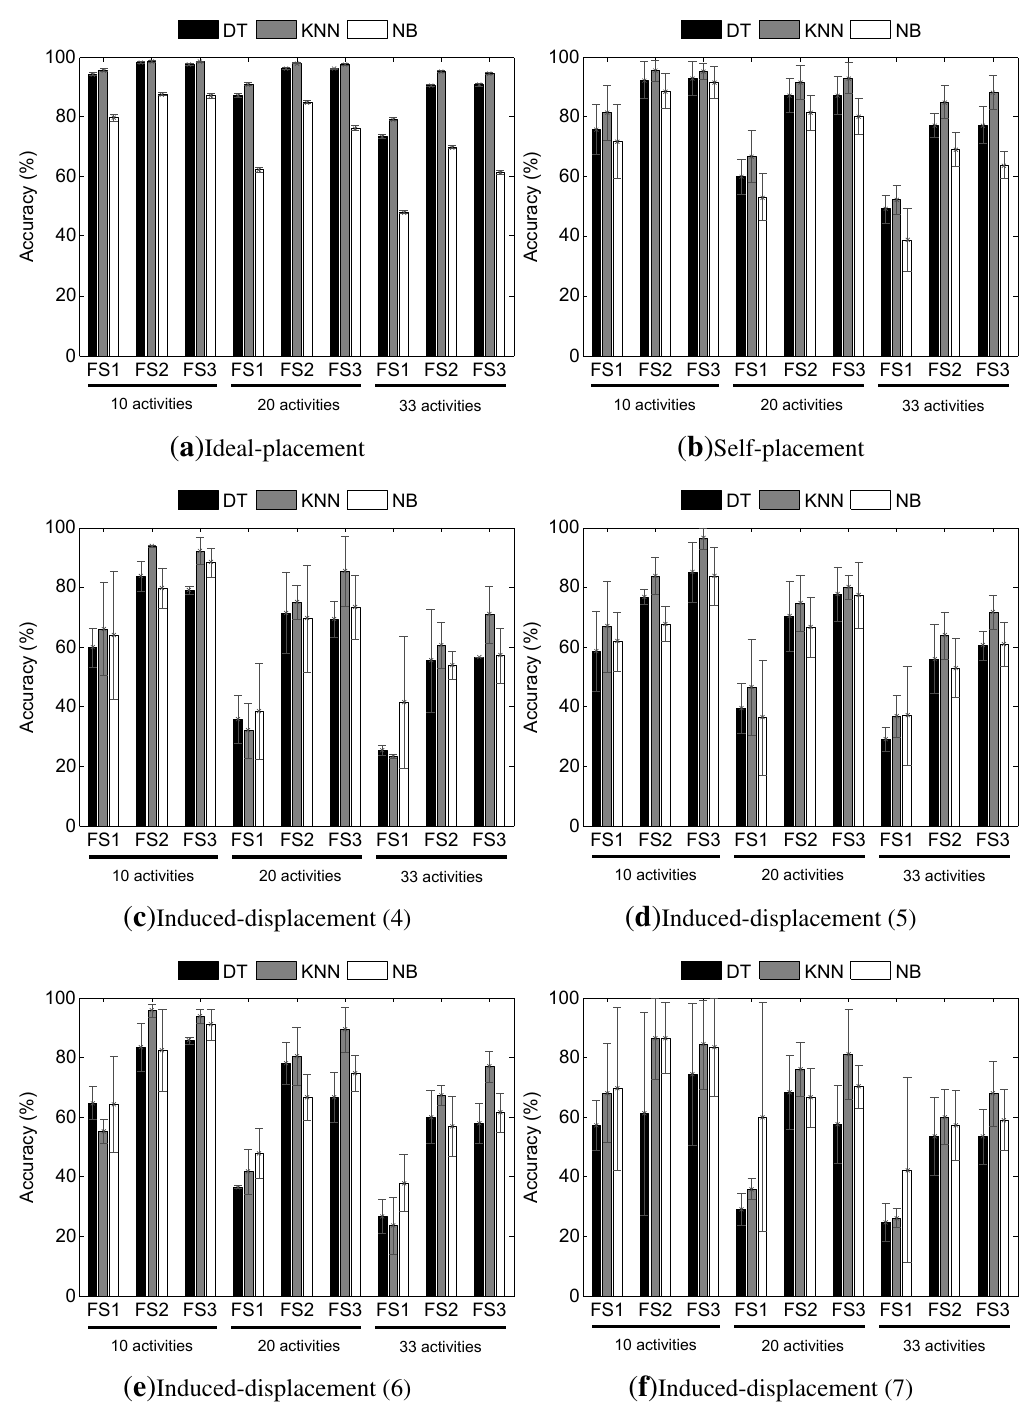
Figure 8. Accuracy (mean and standard deviation) results from the evaluation of the decision fusion model for the ( a ) ideal-placement; ( b ) self-placement and ( c – f ) induced-displacement (number of sensors)